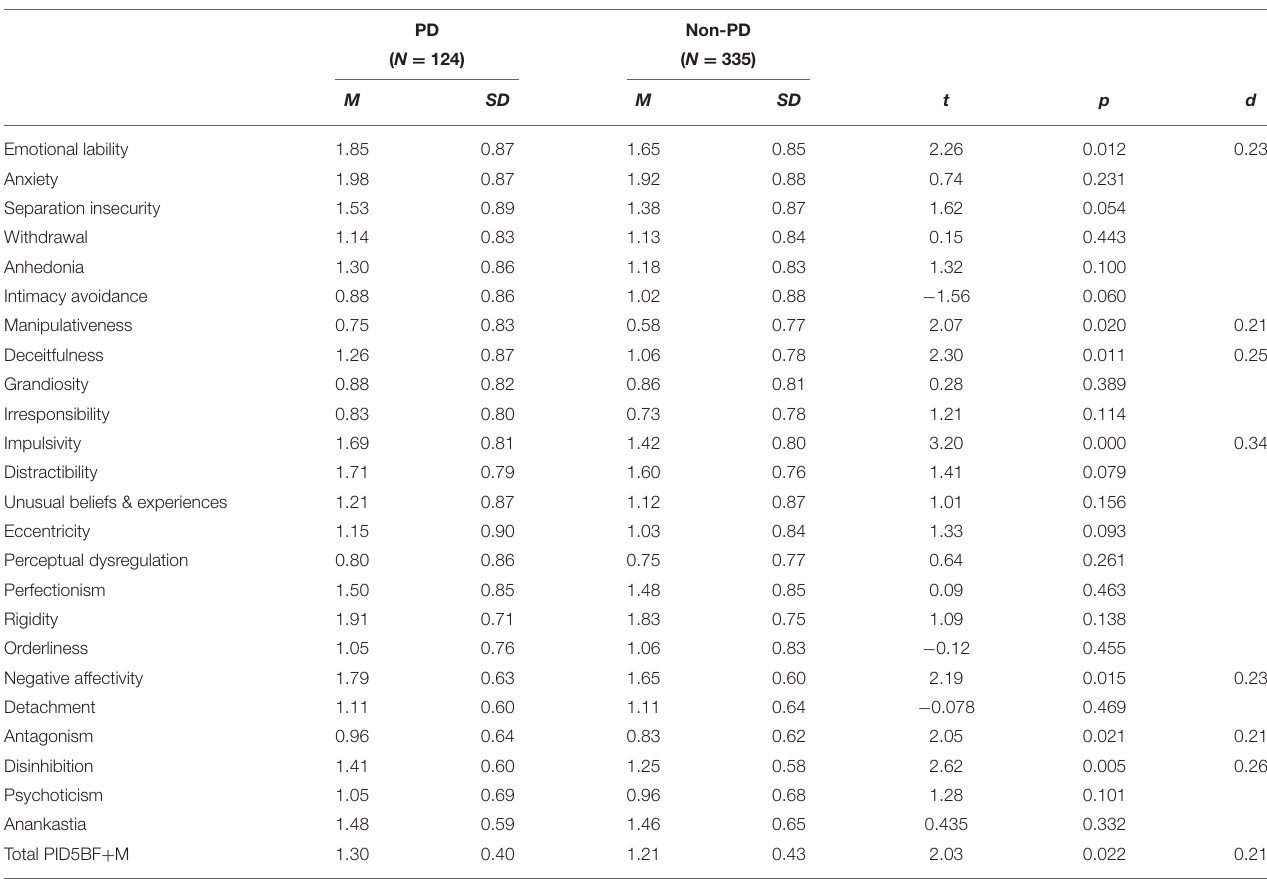
TABLE 1 | PID5BF M scales’ means ( M ), standard deviations ( SD ), t tests ( t ) and effect sizes (d) in the personality disorder (PD) and non-personality disorder + (non-PD) samples.